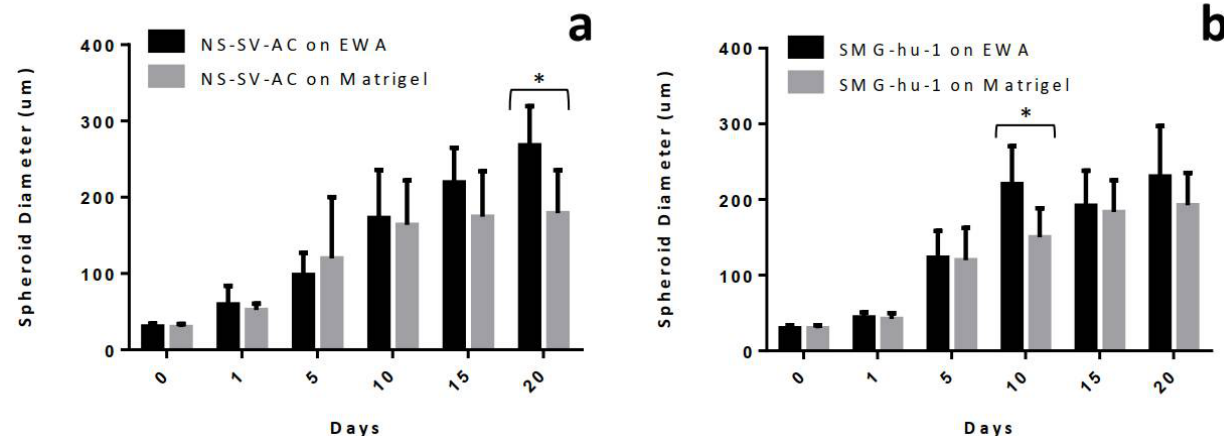
Figure 7. Comparison of average spheroid sizes (in diameter) of cells grown on EWA or Matrigel ® : ( a ) compares NS-SV-AC across EWA and Matrigel ® scaffolds. ( b ) compares SMG-hu-1 across EWA and Matrigel ® scaffolds. The value of each bar shown was reported as a mean where n = 15 for each group. Statistical analyses were performed using a RM two-way ANOVA with Sidak’s multiple comparisons test; * p < 0.05. Data are presented as mean ± standard error (SE). The error bars represent the SE of each measurement.